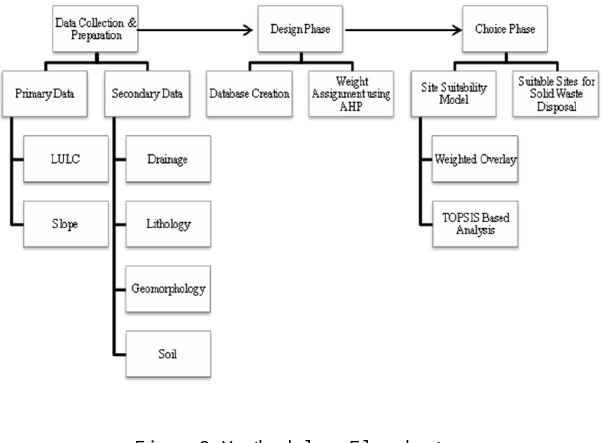
Figure 2. Methodology